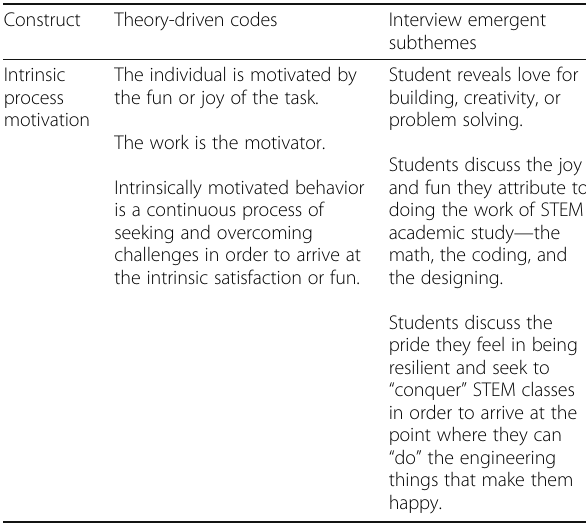
Table 2 Emergent themes related to intrinsic process